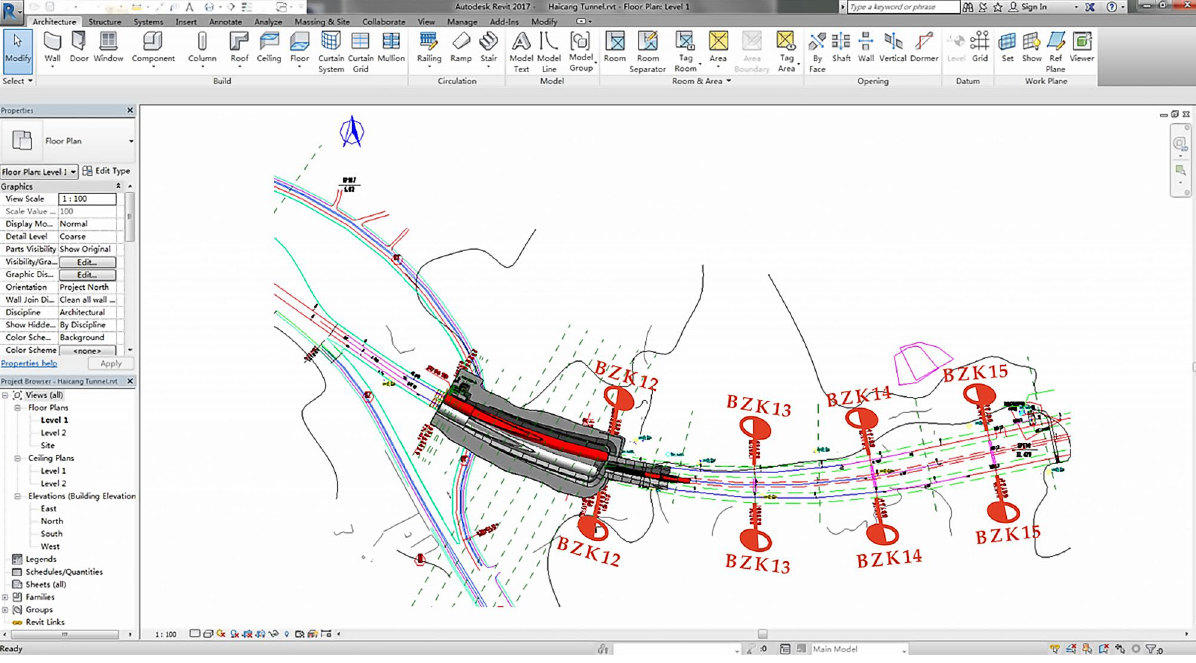
Figure 6. The tunnel model assembled in Revit software